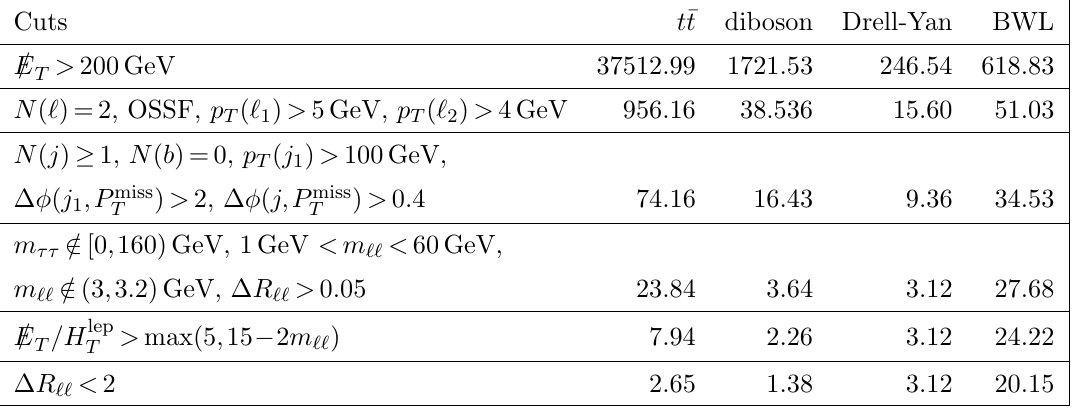
Table 1 . The cut (cid:13)ow for the cross sections of the signal and backgrounds at the 27 TeV HE-LHC for the BWL benchmark point m sections are in units of